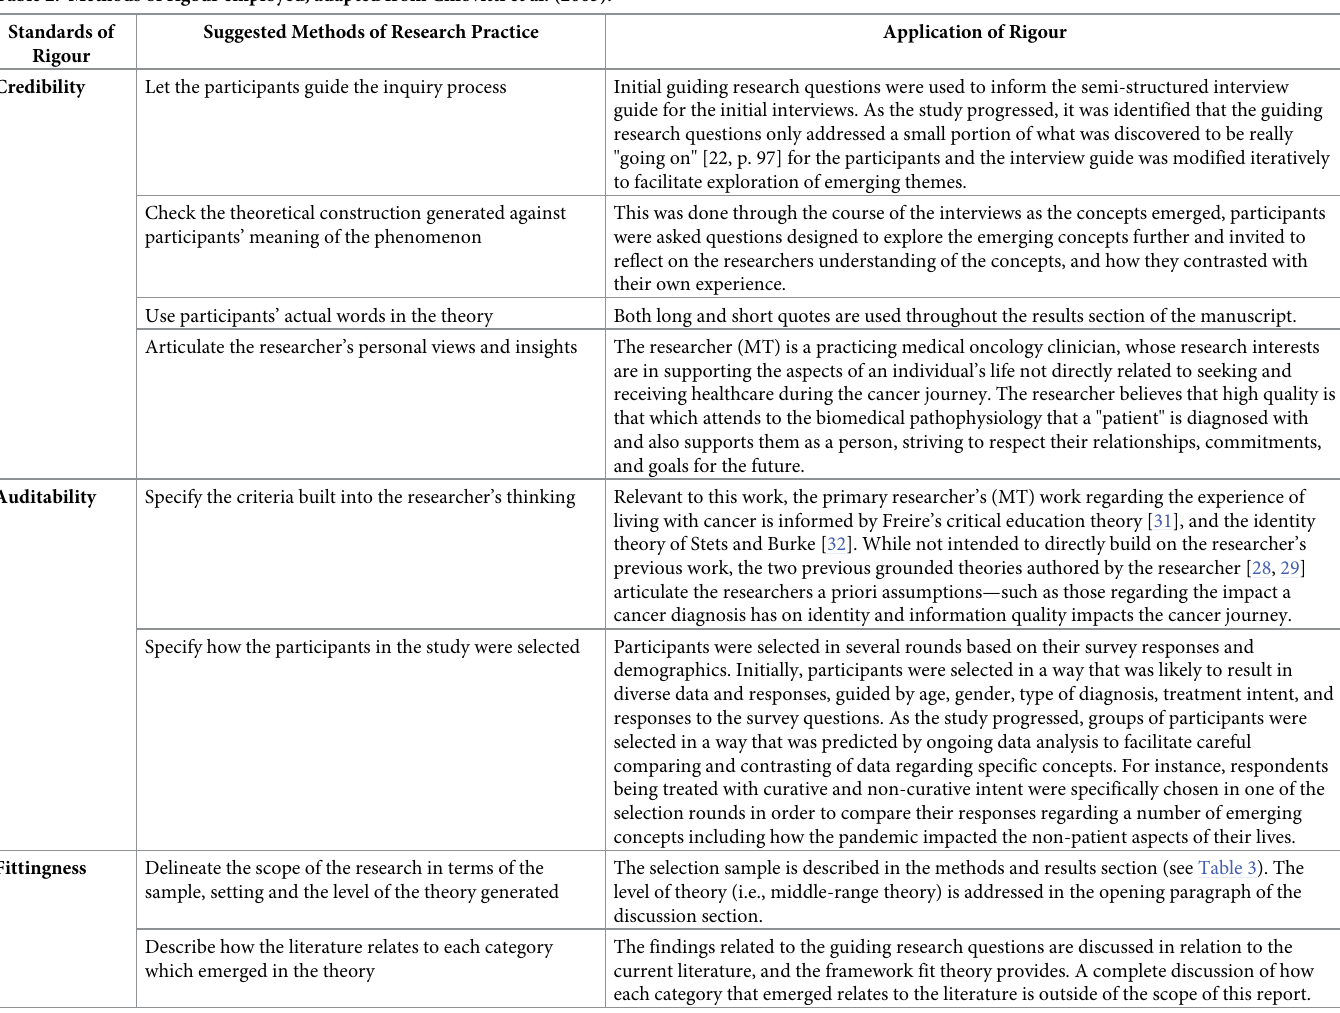
Table 2. Methods of rigour employed, adapted from Chiovitti et al.